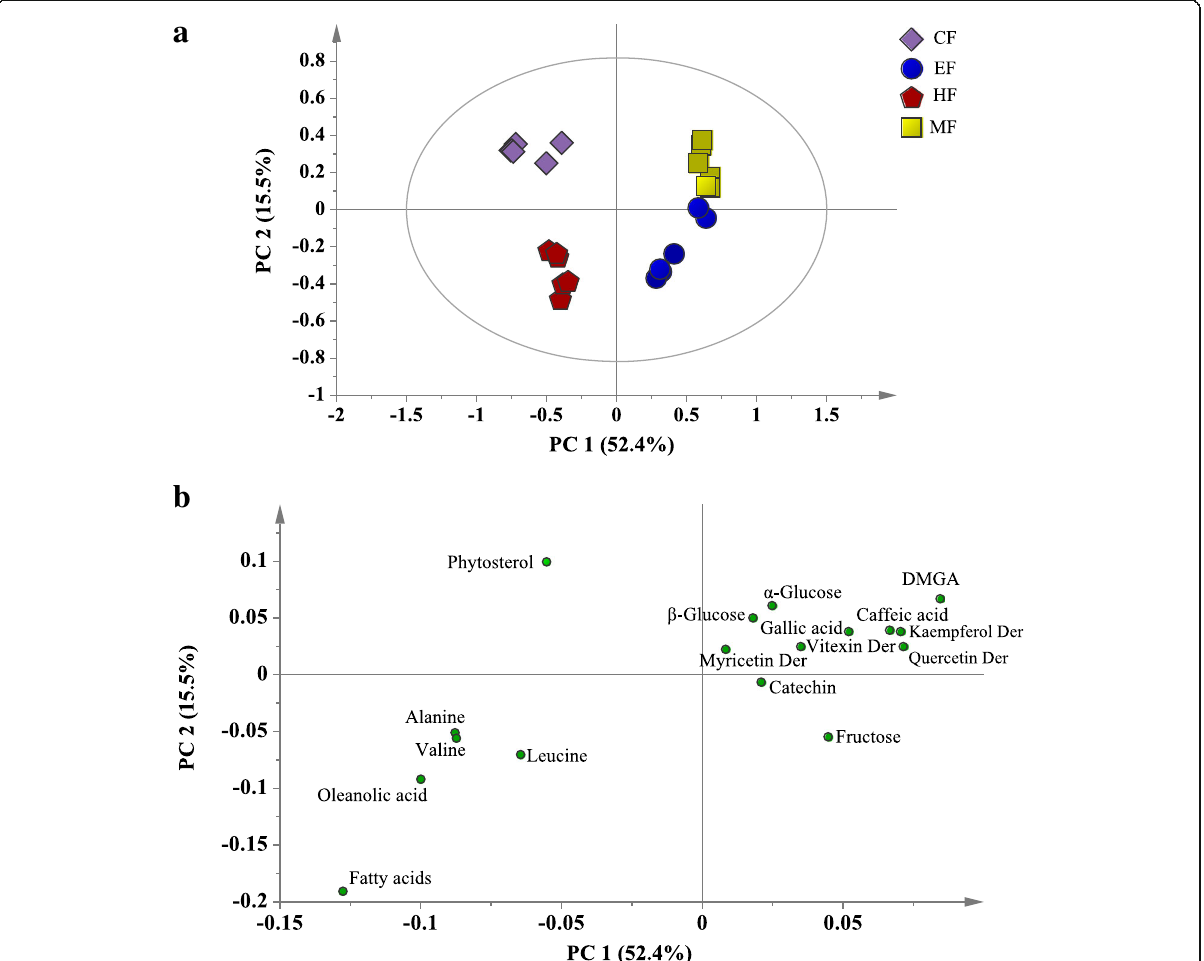
Fig. 2 The PCA score ( a ) and loading ( b ) plots of different fractions of N. oleracea . HF, hexane fraction; CF, chloroform fraction; EF, ethyl acetate fraction; MF, methanol fraction; Der, derivatives; DMGA, 3,4- O -dimethylgallic